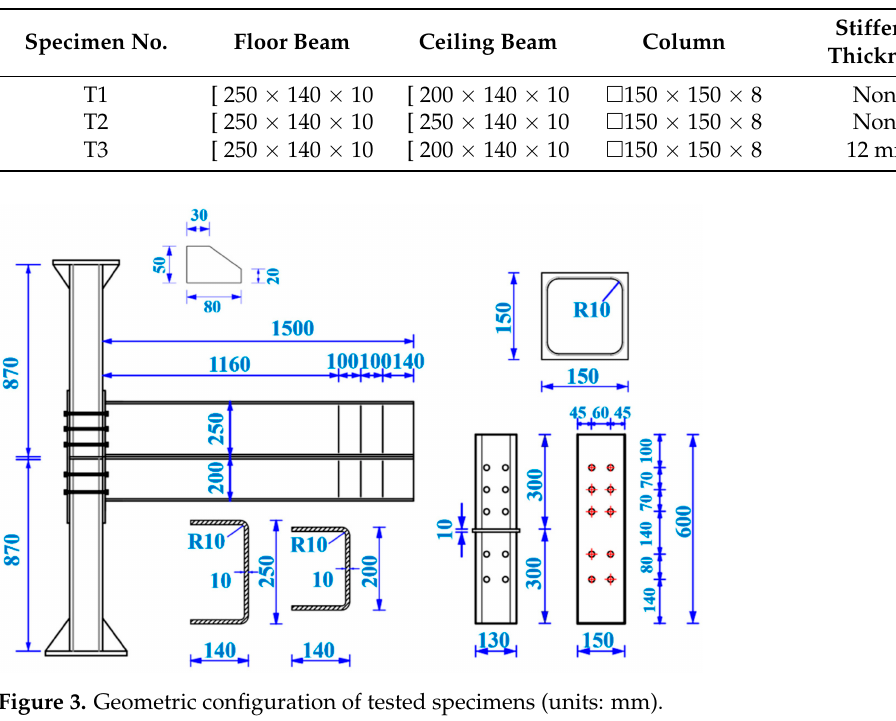
Table 1. Structural members of the tested specimens.